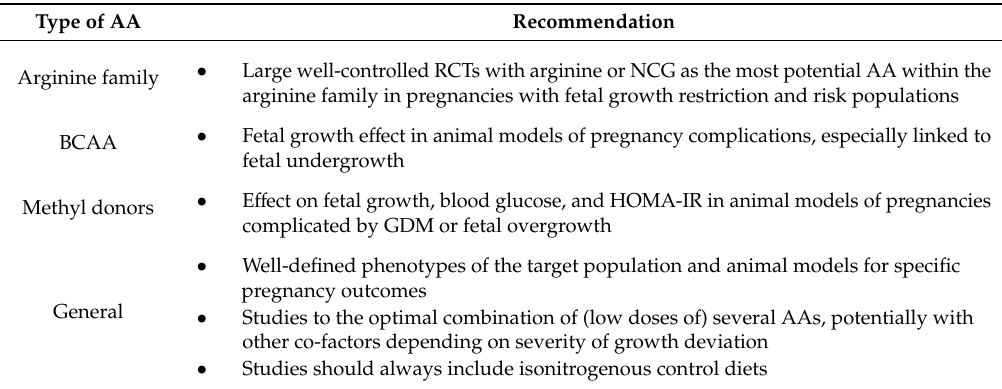
Table 1. Recommendations for future